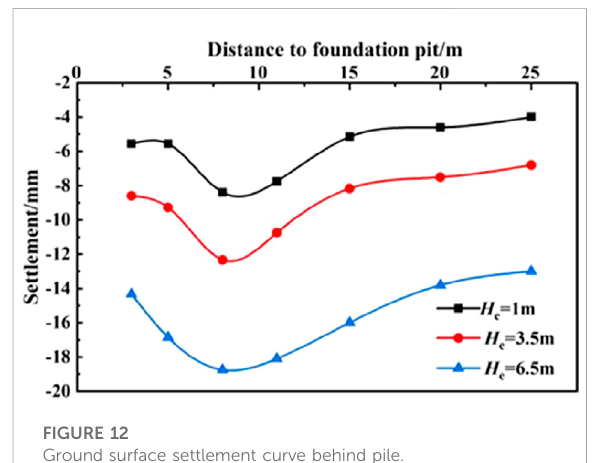
FIGURE 12 Ground surface settlement curve behind pile.